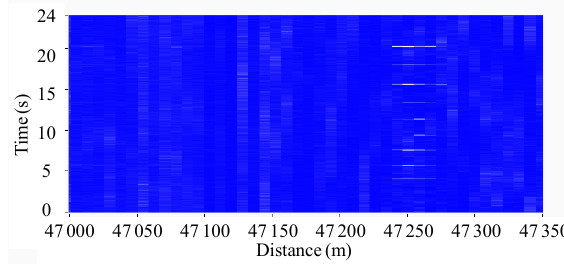
Fig. 23 Waterfall figure of vibration amplitude-time- distance when digging the ground at 1 m distance away from optical